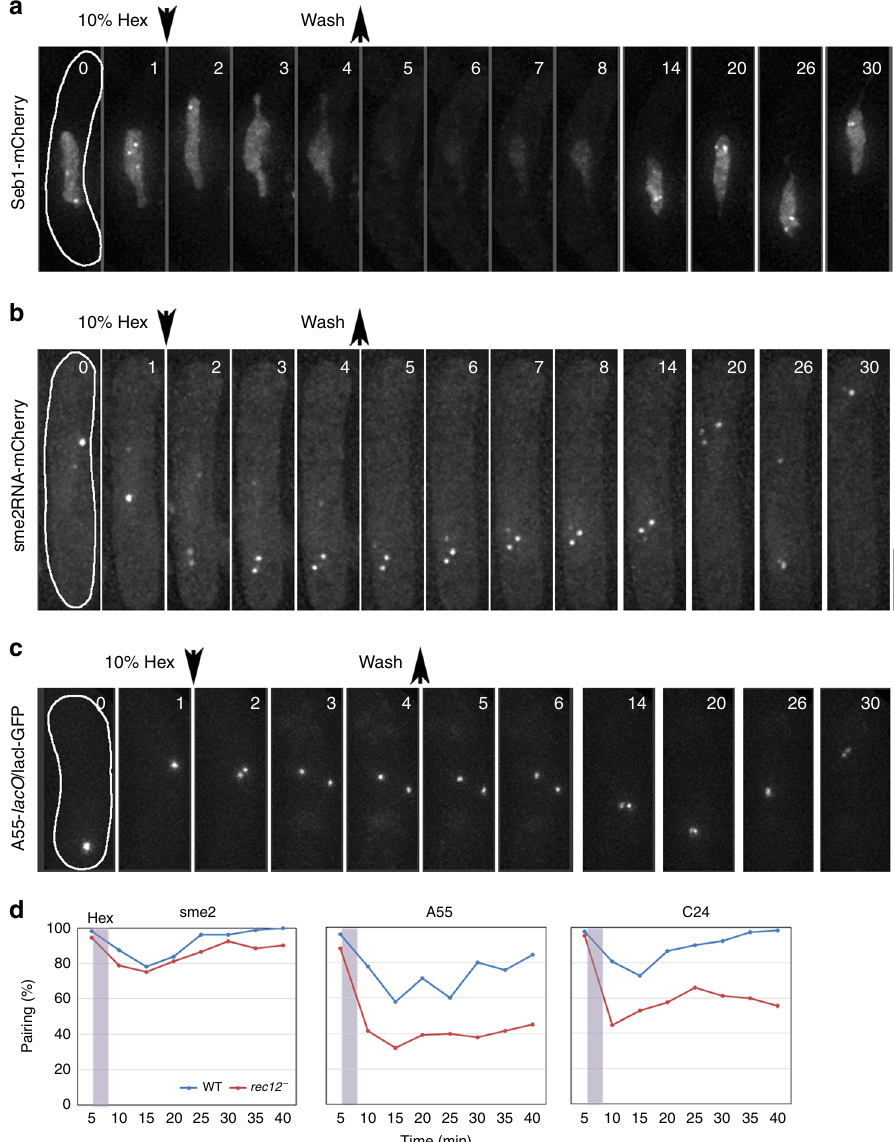
Fig. 5 Liquid-phase separation of Smp proteins and its impact on homologous pairing. a – c Selected projected time-lapse images of live cells at the horsetail stage for Seb1-mCherry ( a ), sme2 RNA-U1Atag/U1Ap-mCherry ( b ), and A55- lacO /LacI-GFP ( c ). The sme2 RNA-U1Atag was visualized by U1Ap- mCherry 11 . Three-dimensional images were captured every minute. Micro fl uidic yeast plates (CellASIC) were used for cell culture on the microscope stage. 1,6-Hexanediol (10%) was added or removed, as indicated by the arrows. The solution in the cell culture chamber was changed at <1 min. Scale bar, 5 μ m. d Number (%) of cells with paired chromosomes at sme 2 (left), A55 (middle), and C24 (right) loci. 1,6-Hexanediol was added to WT and rec12 deleted ( rec12 − ) cells at 5 min and removed at 8 min (treatment period is shaded in the graphs). Three-dimensional live cell images were captured every minute, and the percentage of paired cells observed at 5-min intervals is shown. Source data for Fig. 5 are provided as a Source Data fi le